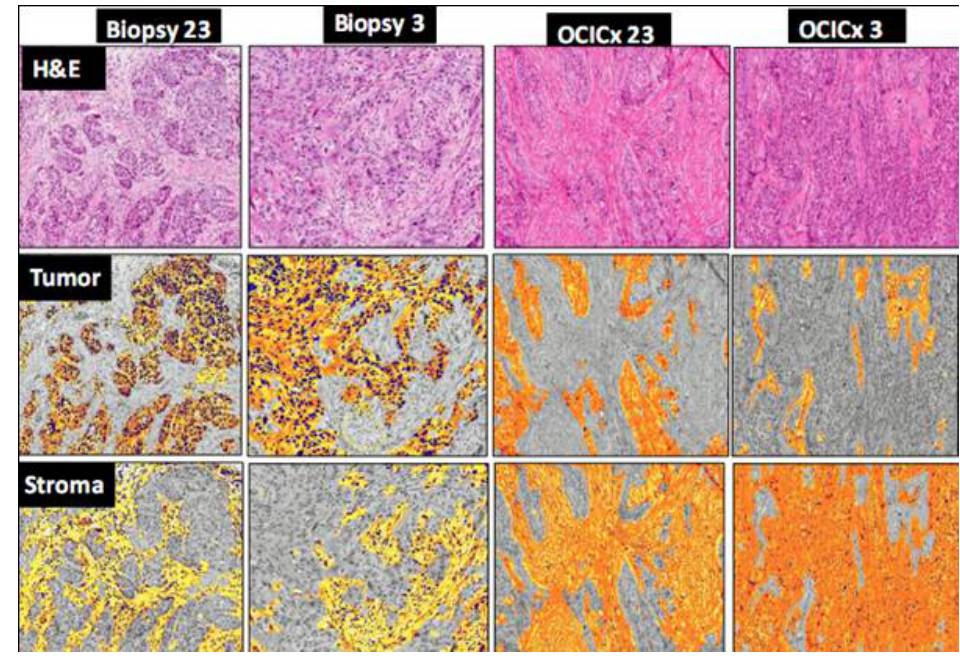
Figure 4. Genie images of tumor and stroma components in the biospy and OCICx. A panel of IHC staining for Biopsy 23 and Biopsy 3 showing H&E patient biopsy, positive pixel mask for tumor components; positive pixel mask for stroma components. Staining for OCICx 23 and OCICx 3 respectively H&E patient biopsy, positive pixel mask for tumor components; positive pixel mask for stroma components. 15×